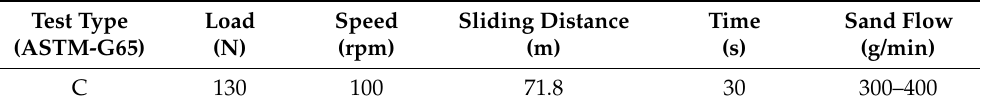
Table 2. Test parameters for the wear assays according to the ASTM-G65 standard